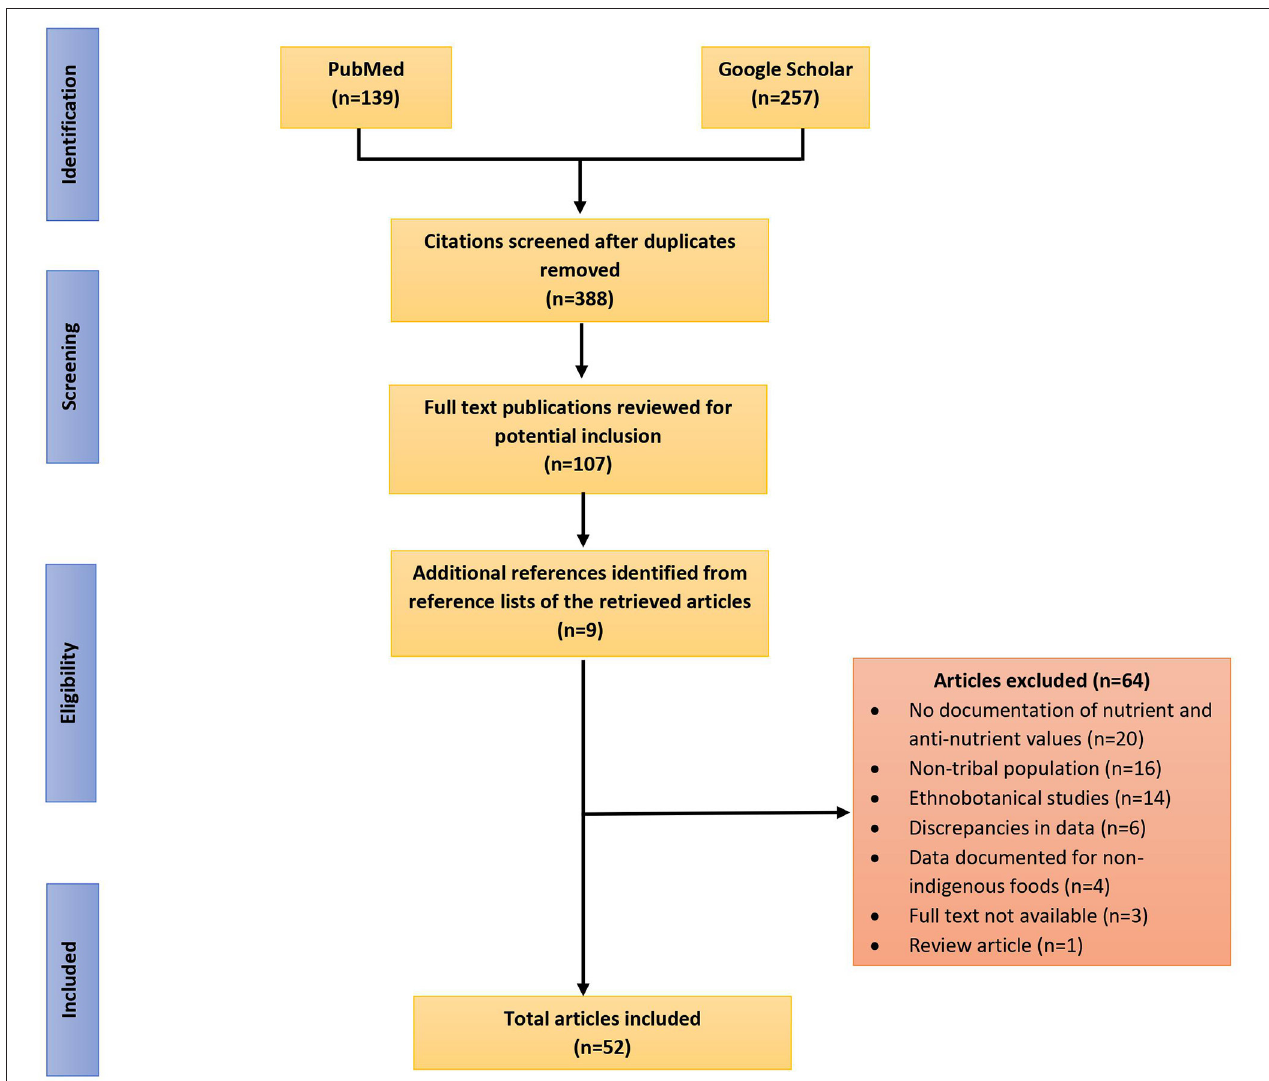
FIGURE 1 | Flow diagram reporting the screening and selection process used in identification of research studies reporting nutritive values and antinutritional content of indigenous foods consumed by and known to indigenous communities of